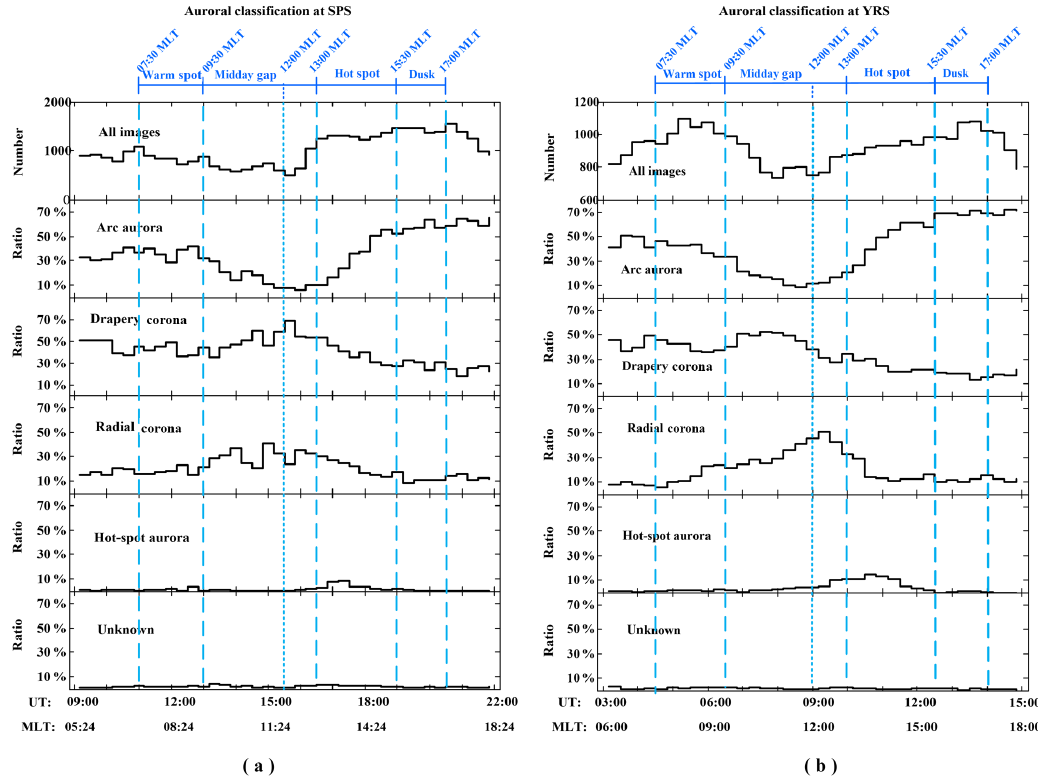
Figure 4. Temporal occurrence distributions of auroral types at SPS (a) and YRS (b) : from top to bottom, panels show the distributions of numbers of images (top panel), four categories of dayside auroras (second to fifth panels) in ATD1 and ATD2, and the unknown images in both